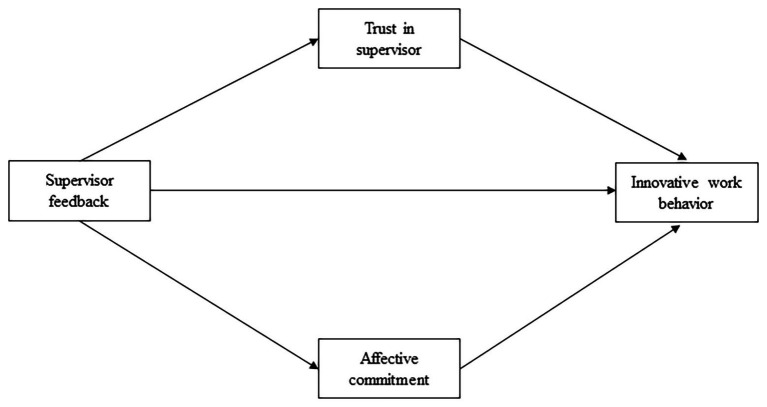
Hypothesized model.